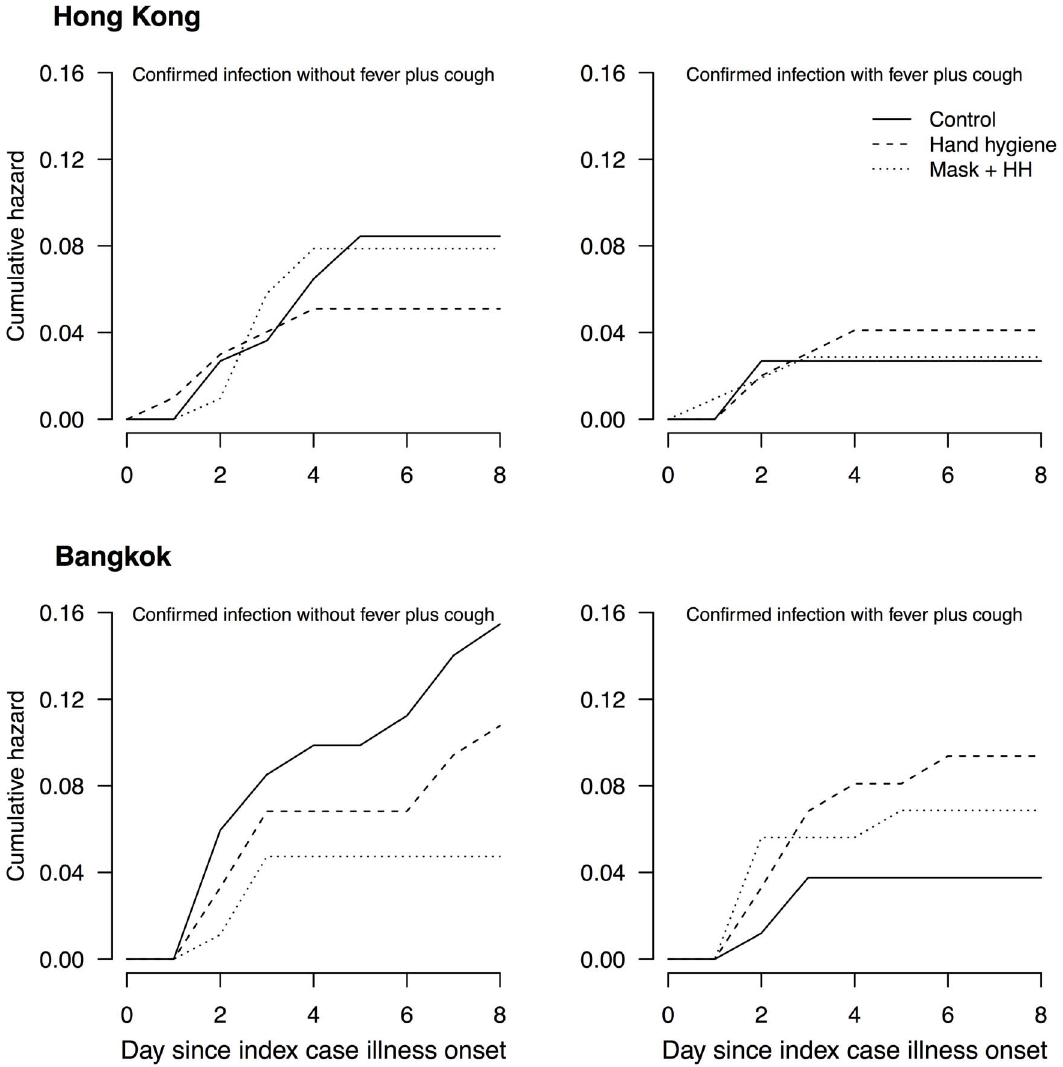
Figure 1. Cumulative hazards of RT-PCR-confirmed influenza B virus infections presenting with fever plus cough or not presenting with fever plus cough, among the household contacts in 104 and 113 households of index cases with RT-PCR-confirmed influenza B virus infection in Hong Kong and Bangkok, respectively.